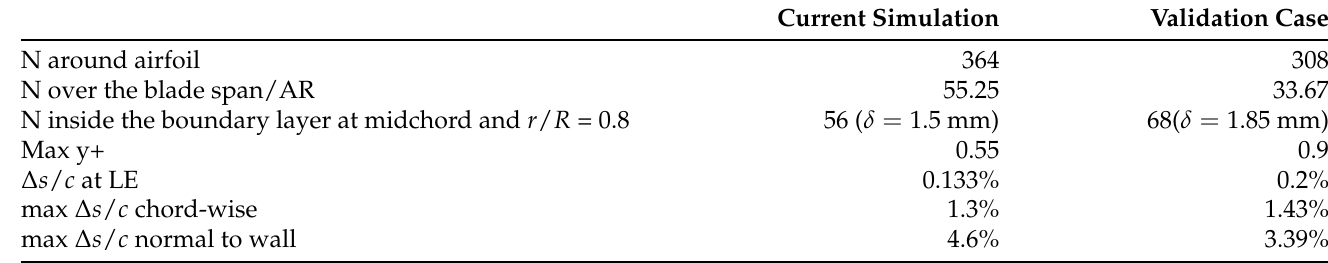
Table A3. Comparison of the spatial resolution between current simulation and validation case.